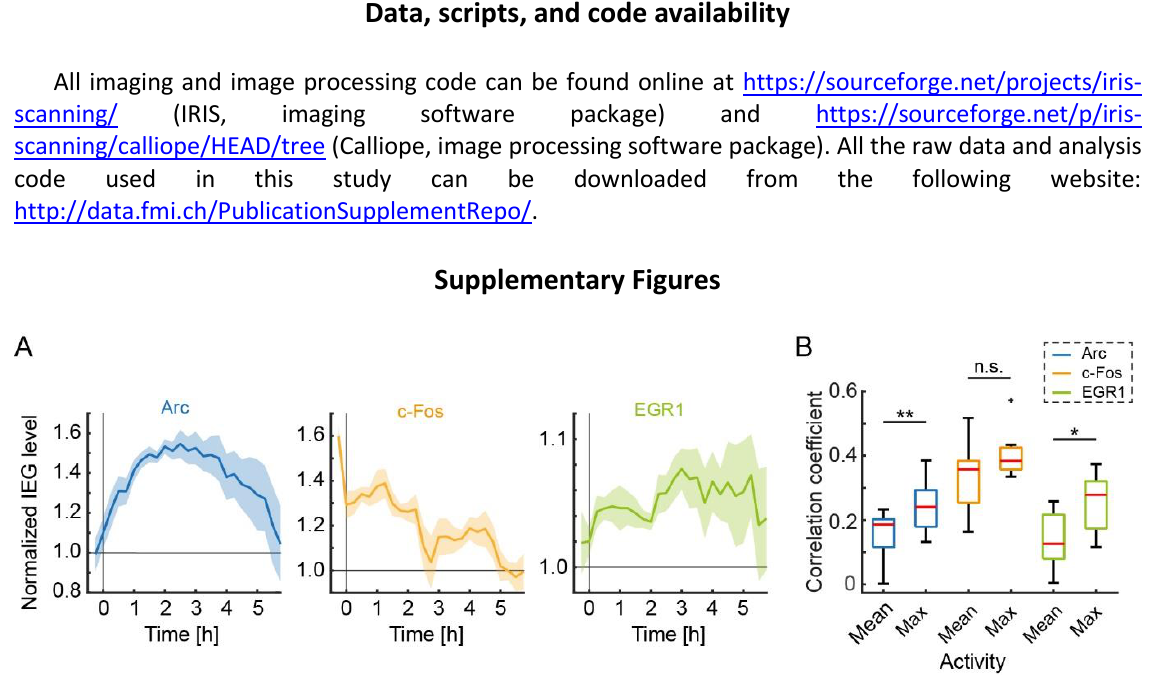
Figure S1. Time course of IEG expression during the imaging paradigm and correlation of IEG expression with mean and maximum neuronal activity. Related to Figure 1. ( A ) Time course of normalized IEG expression levels following 24 h dark adaptation and 15 min visual stimulation at time 0. Shading indicates SEM over neurons. ( B ) Correlation coefficient of mean and maximum activity (average across or peak within a recording session, respectively) with IEG expression 3.5 h after stimulation or recording onset (Arc: 11 mice, c-Fos: 9 mice, EGR1: 8 mice). Box whisker plot: red line indicates median, box marks 25th to 75th percentiles and whiskers extended to the next most extreme datapoint within a range of 1.5 times the interquartile distance (rank sum test, Arc: p = 0.0086, c-Fos: p = 0.1359, EGR1: p =